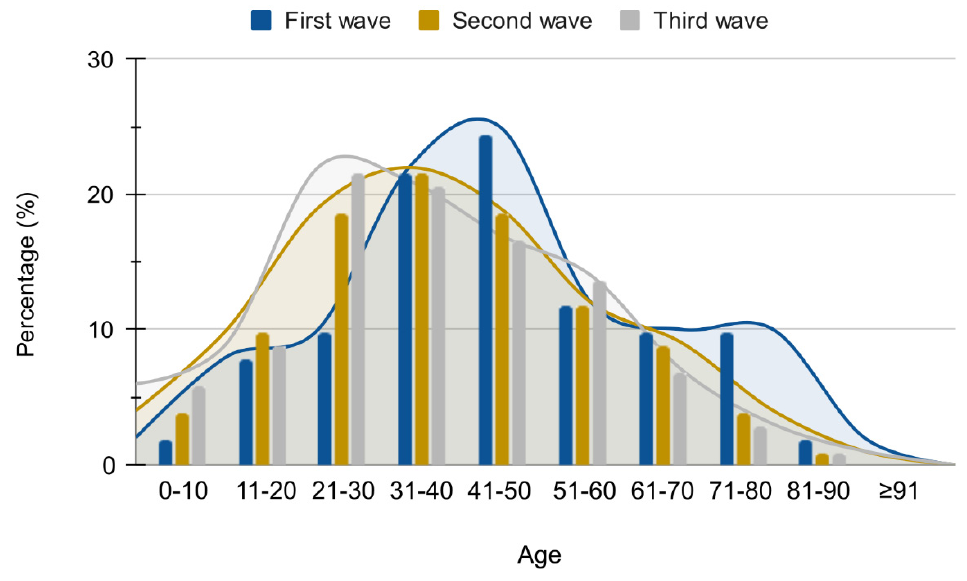
Figure 1. Distribution of patients according to age during the three SARS-CoV-2 epidemic waves. The X-axis contains the intervals of ages, including 0 until ≥ 91 years old. The axis Y represents the percentage of individuals positive for SARS-CoV-2 during each epidemic wave.